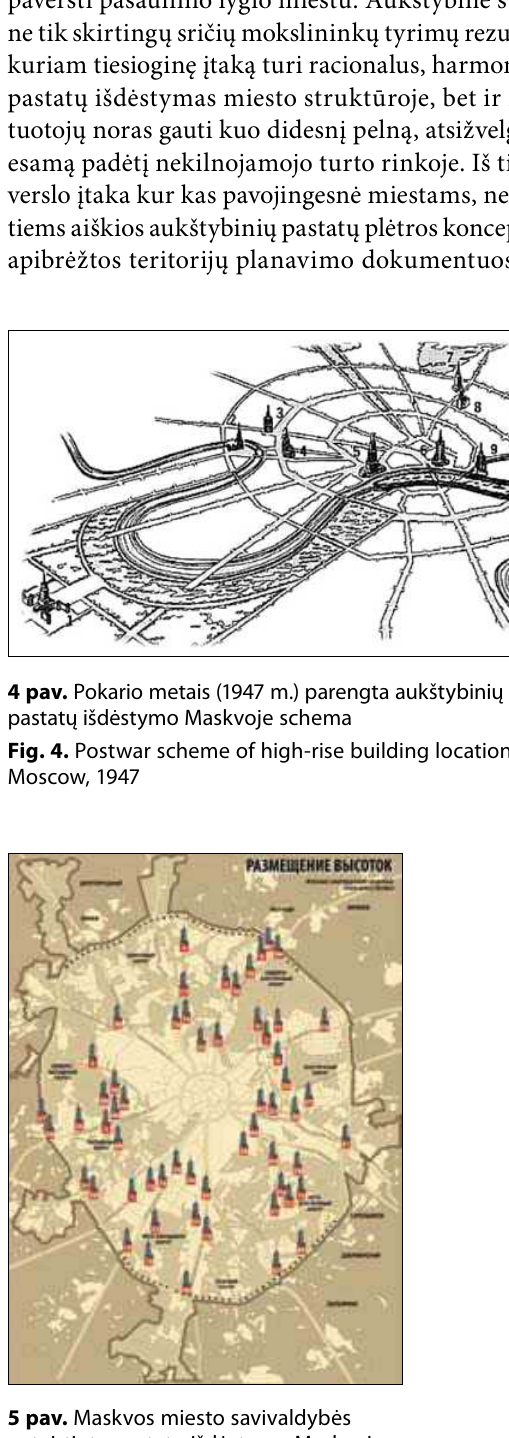
Fig. 5. high-rise building